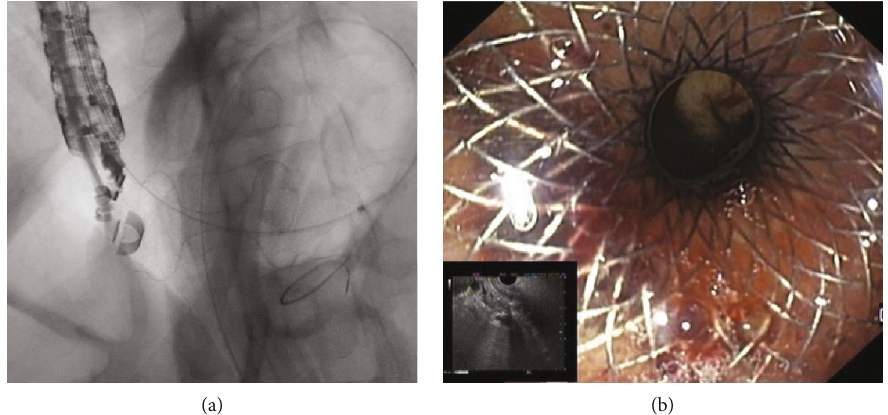
Figure 3: Patient with a previous Roux-en-Y gastric bypass who presented with jaundice secondary to pancreatic cancer underwent endoscopic ultrasound directed transgastric ERCP (EDGE). (a) Fluoroscopic image showing a 20mm diameter lumen apposing metal stent (LAMS) placed between the gastric pouch and the gastric remnant under EUS guidance. (b) Endoscopic image of the proximal fl ange of the LAMS in the gastric pouch.